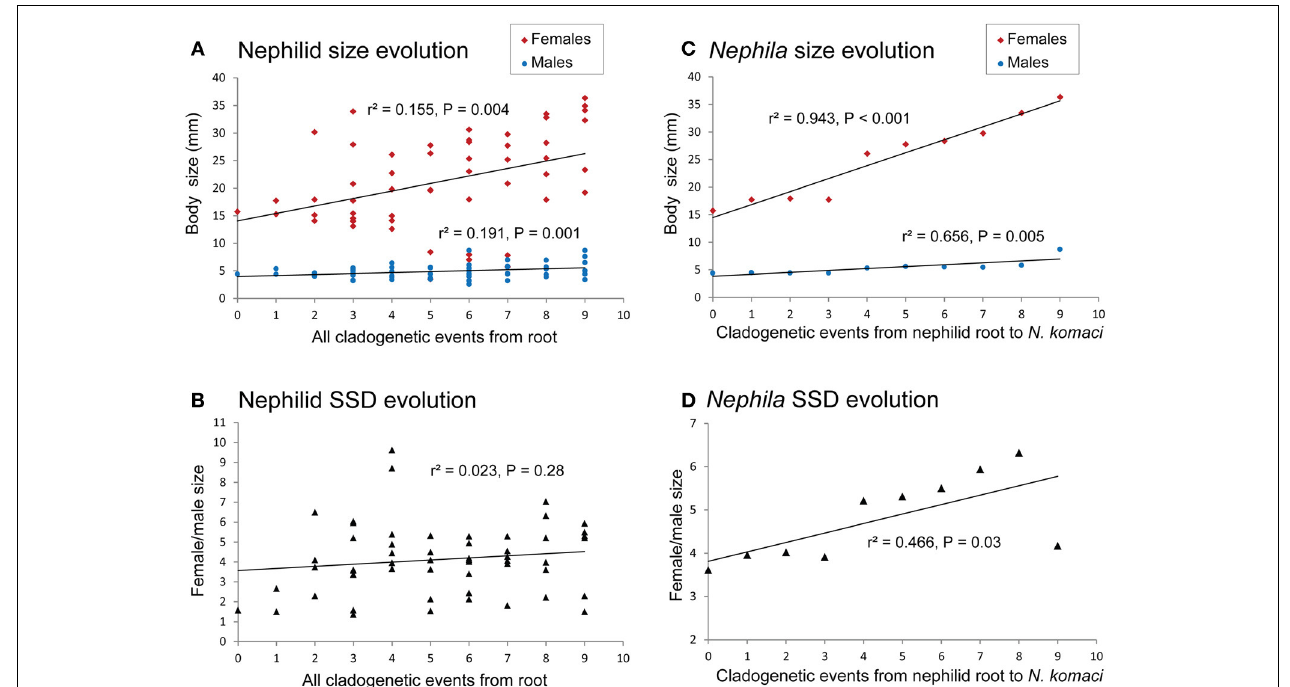
FIGURE 3 | Reconstructed evolutionary changes in female and male size and sexual size dimorphism. The phylogeny postulates 10 cladogenetic events (on x axis) that together correspond to an evolutionary history of 40–60 million years estimated for the family (Kuntner et al., 2013). Nephilid size evolution (A) takes all phylogenetic nodes leading to all terminal taxa across the nephilid phylogeny